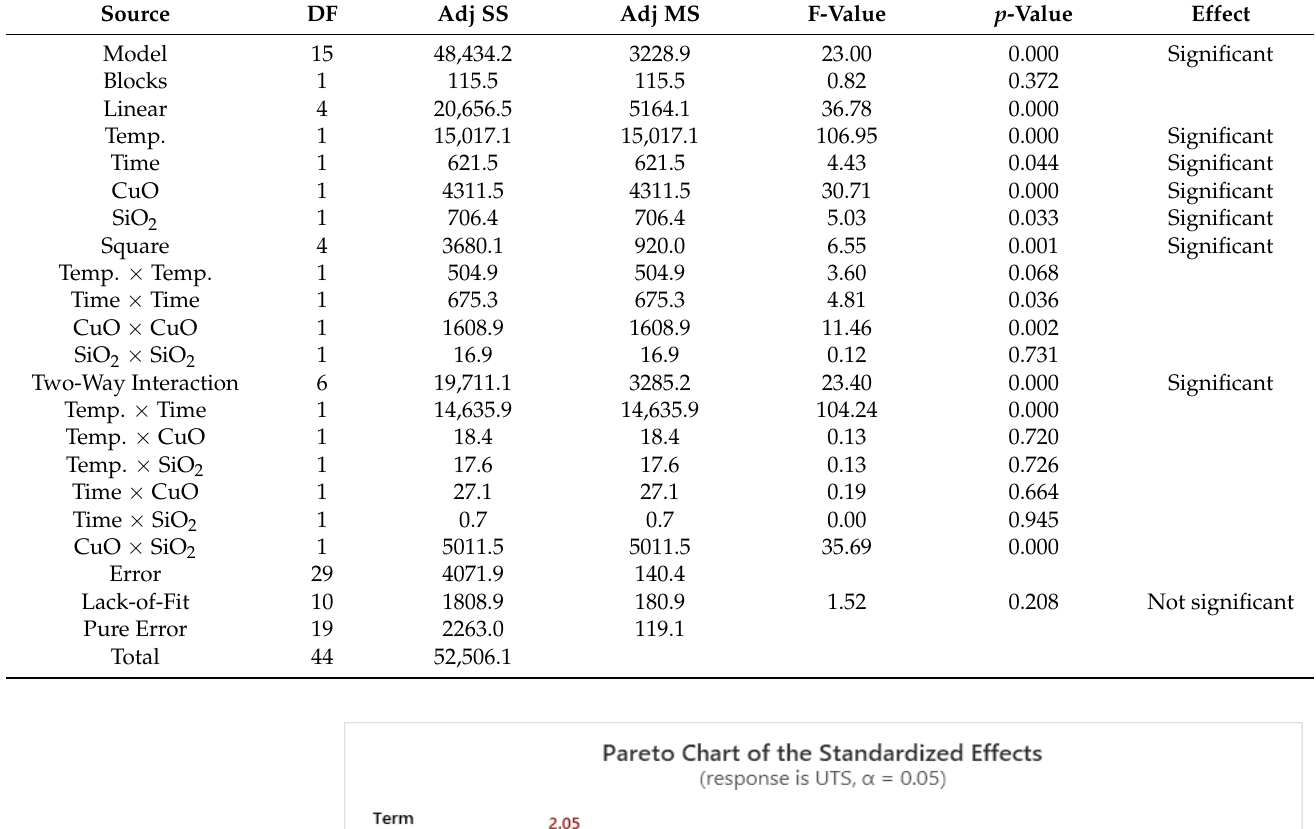
Table 5. The Analysis of Variance of UTS by RSM.